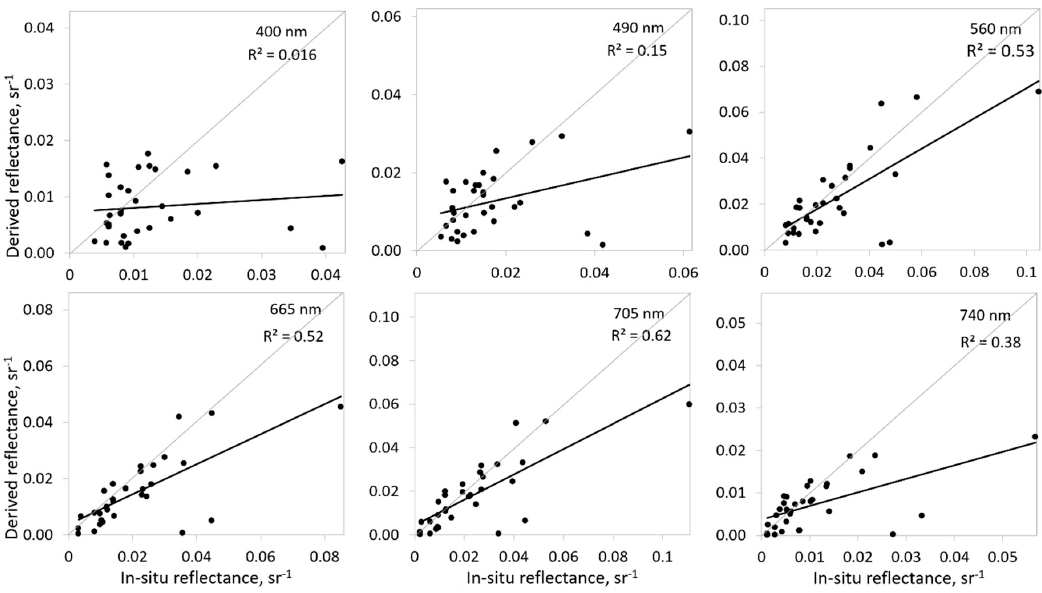
Figure A3. The comparison of the in-situ and MSI C2X spectral Figure B2. The comparison of the in-situ and MSI C2X spectral bands. Figure B2. The comparison of the in-situ and MSI C2X spectral bands.